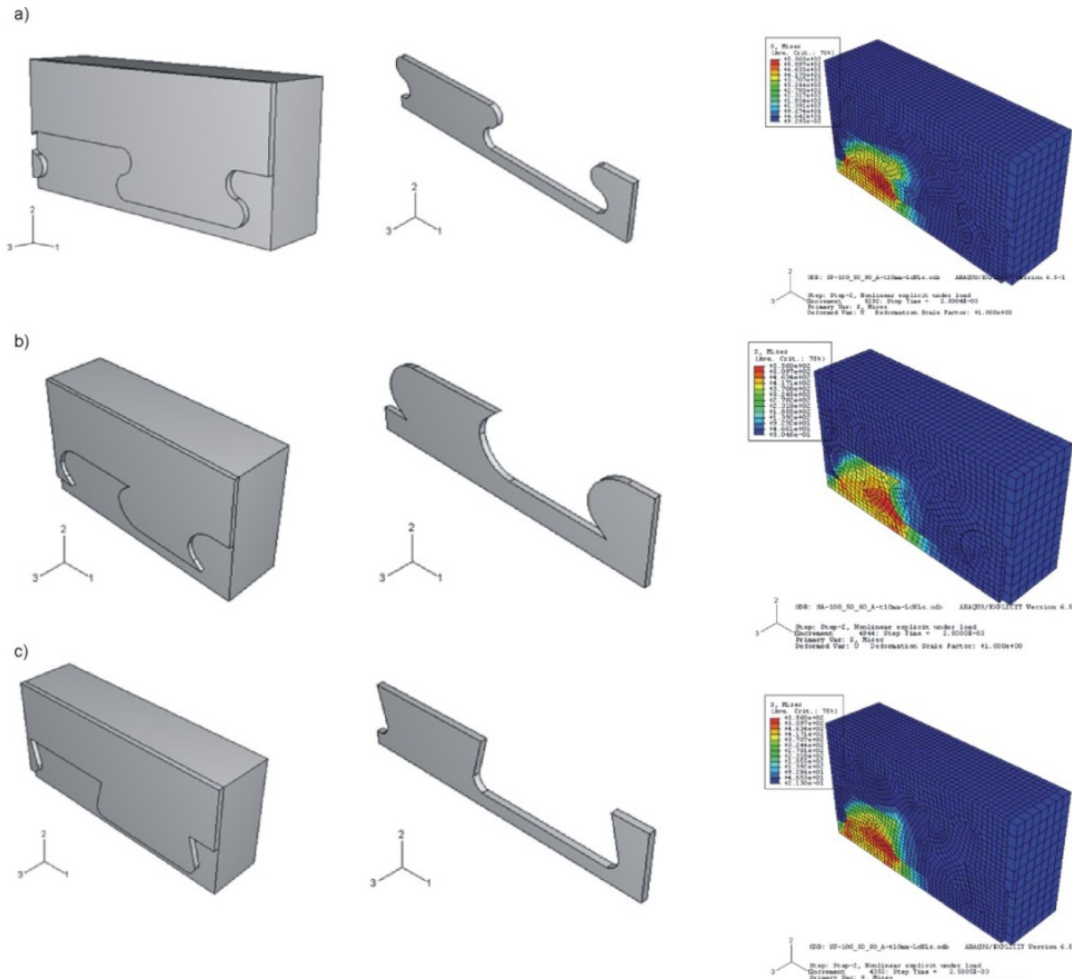
Figure 22: 1D1 models (geometry of the concrete part, steel part, and reduced stress layout, providing a general view of the yielded steel part) studied for the purposes of [7]: a) PZ shape (also called SP), b) SA shape, and c) SV shape.